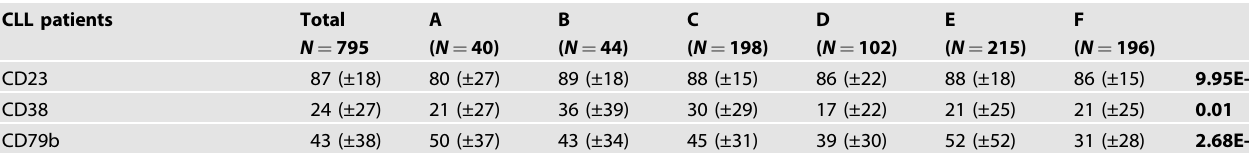
tions: BTK inhibition related protocols (±venetoclax), antibody only therapy, or chemo/chemoimmunotherapy regimens. As shown in Fig. 4, multiple PFG were prognostic ( P ≤ 0.05) for OS within each therapy subclass; 25 with BTKi, 18 for chemo, and three for AB therapy. Interestingly Metabolic Glucose and BCR PFG clusters have survival disparities when treated with BTKi and chemoimmunother- apy. The Metabolic Glucose PFG has two favorable (C2-C3) and two unfavorable clusters (C1, C4) when treated with BTKi (Fig. 4 inner plots). Remarkably, the two unfavorable clusters have nearly opposite expression patterns of several glycolytic proteins (Supple- mentary Fig. S18) but share low expression of PRKAA1.2.pT172, implicating pathways activated by PRKAA1.2.pT172 in BTKi sensitiv- ity or response. The SGs (Fig. 5) remain prognostic for OS regardless of therapy group, and for TTST for the chemo group. Thus, proteomic assignment is prognostic across therapy types at the level of PFG and SG. Of note, SG-A had the poorest OS in both chemotherapy and BTKi therapy types.